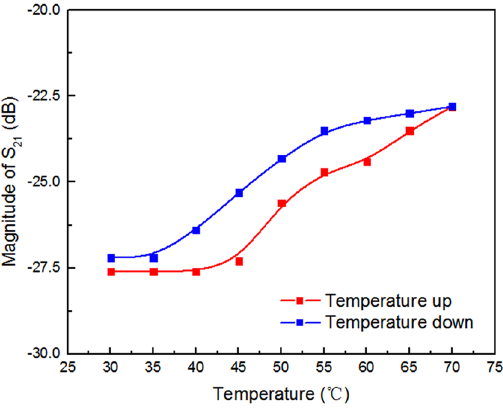
Figure 3. Measured temperature-dependent hysteresis curve of transmission at 8.88 GHz with incident power set to − 15